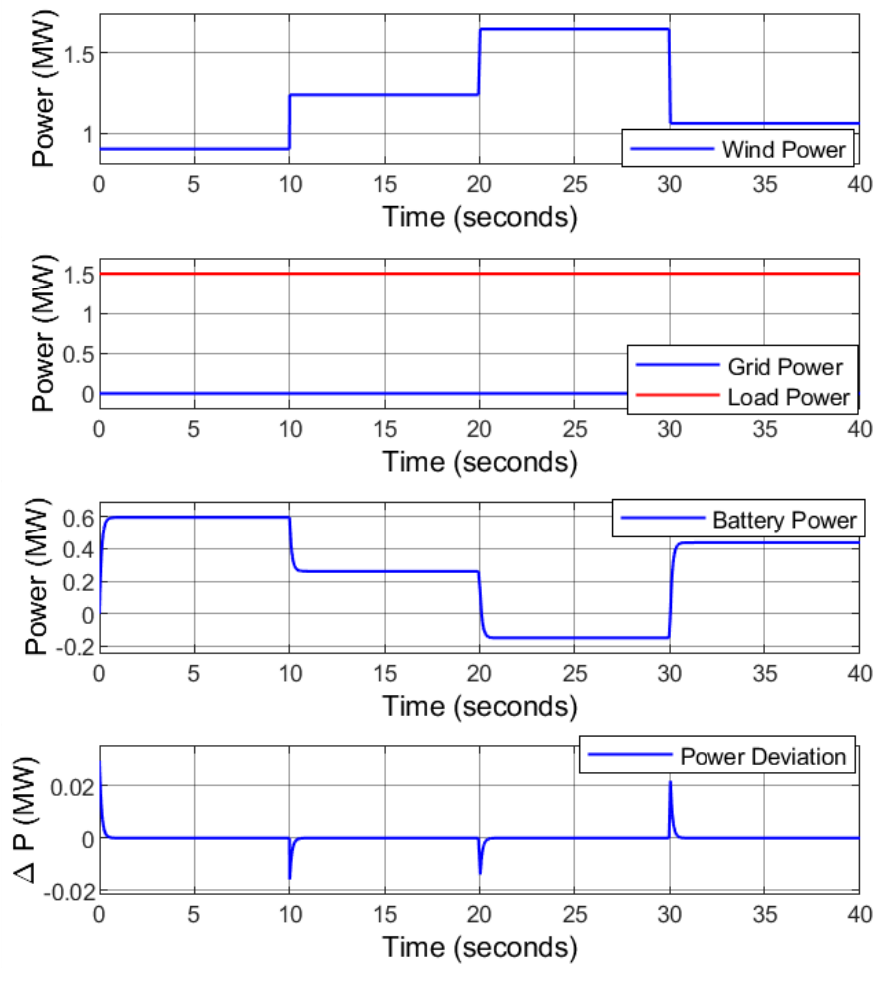
Figure 8. Scenario 2: power management of the microgrid.